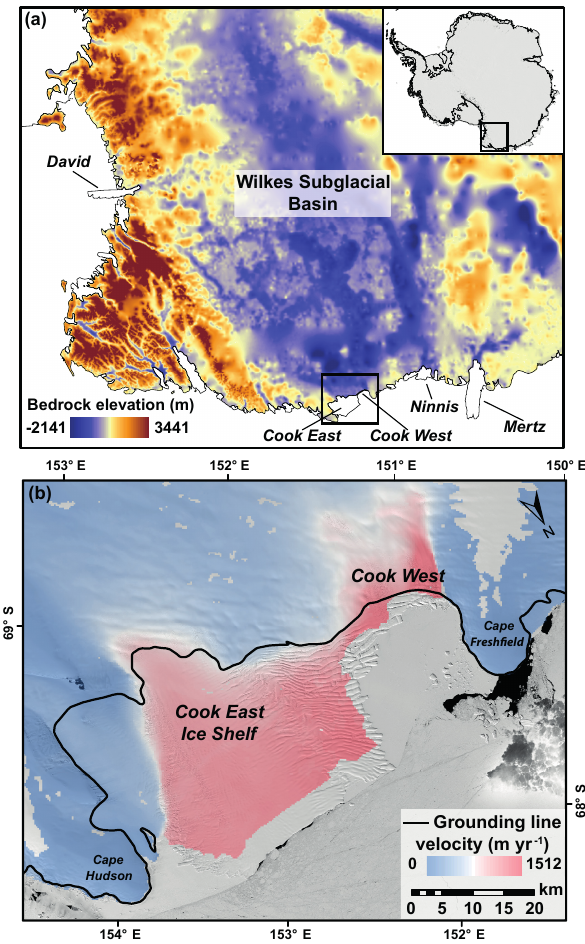
Figure 1. (a) Bedmap2 bed elevation of the Wilkes Subglacial Basin (Fretwell et al., 2013); note that Cook East and West drain a large proportion of the Wilkes Subglacial Basin. (b) Landsat-8 image of Cook East and West glaciers from February 2017, overlain with velocities (Rignot et al., 2011) and grounding line (Depoorter et al.,